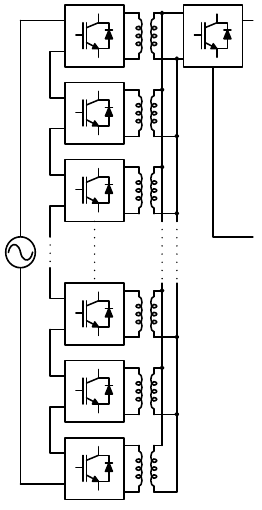
Figure 1. Solid state transformer.